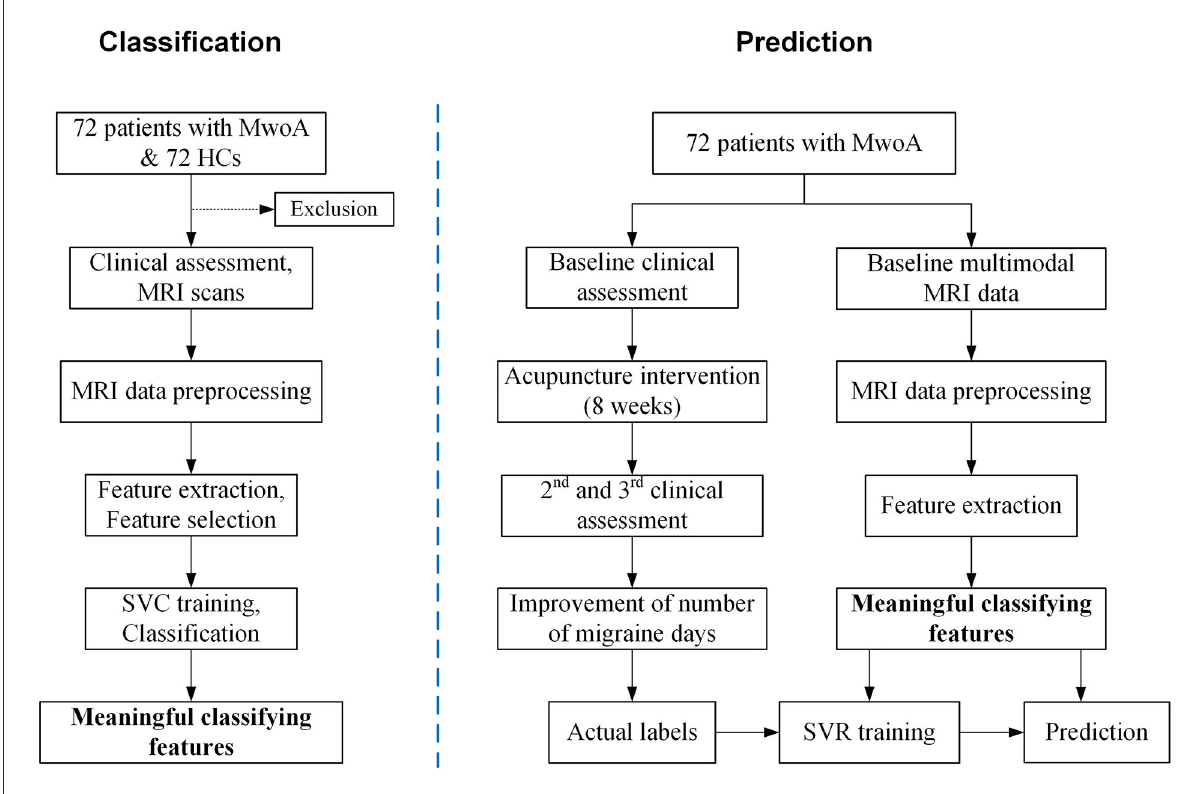
FIGURE1 Study flowchart. The flowchart of this